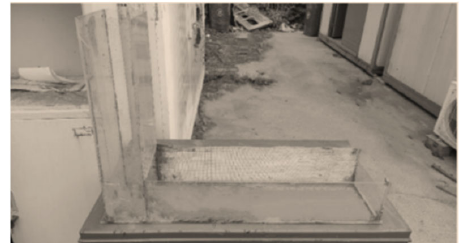
Figure 3. L chute. Figure 3. L chute.